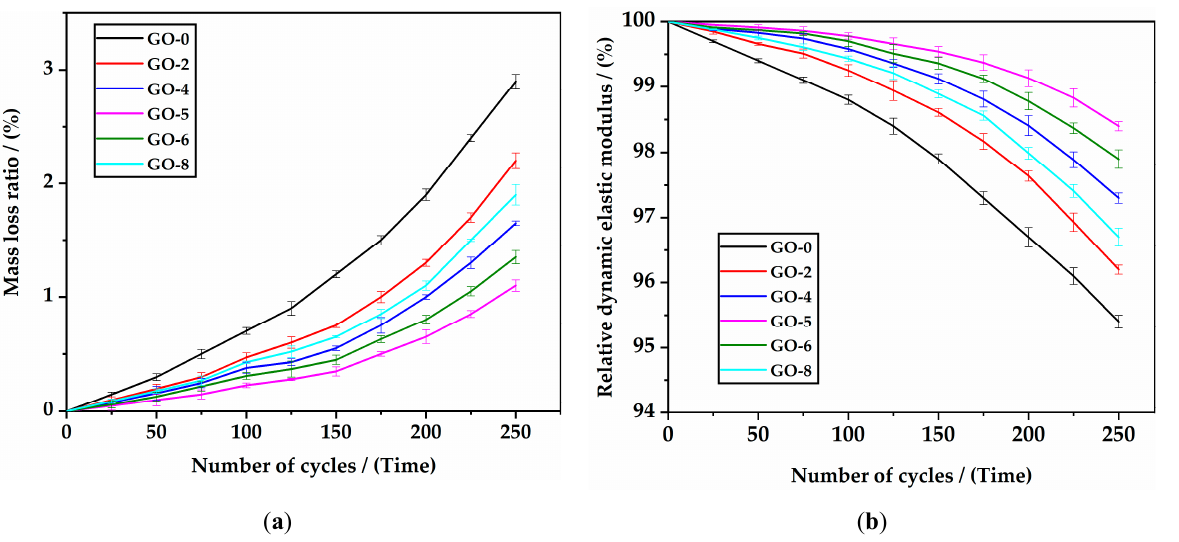
Figure 11. Freezing and thawing results of HSLWC with different GO incorporation contents: ( a ) the mass loss rate; ( b ) the relative dynamic elastic modulus.